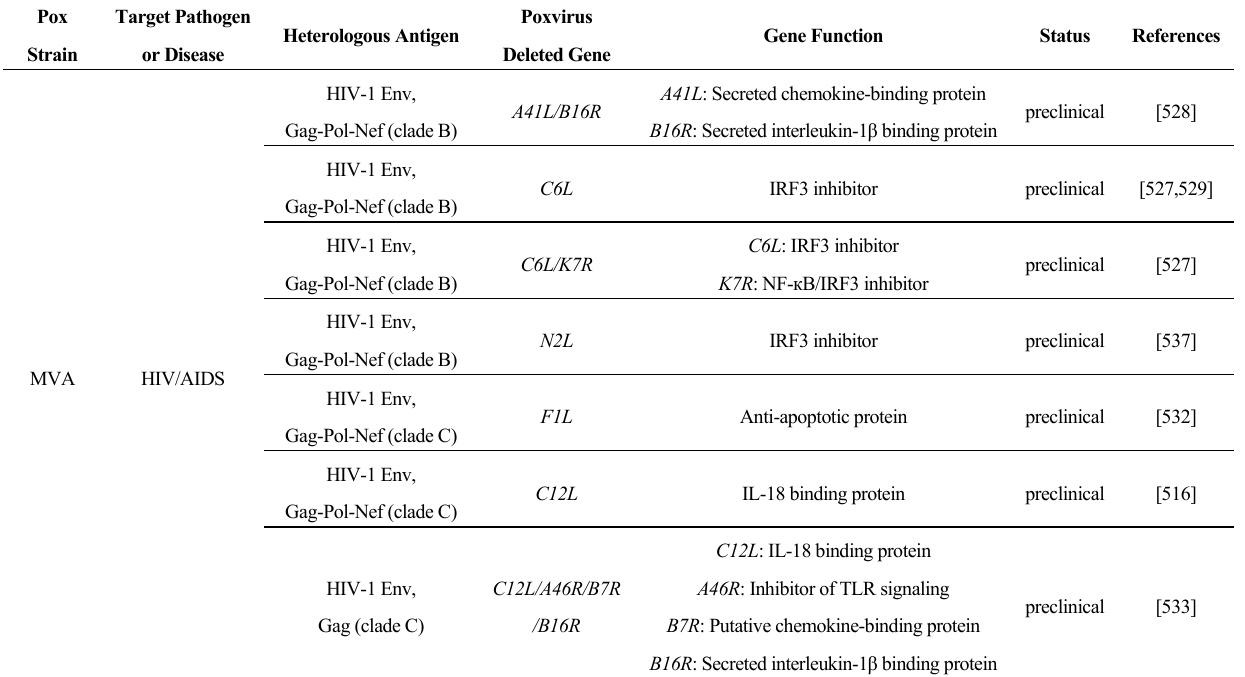
Table 9. Poxvirus genes deleted in poxvirus-based vaccine candidates against infectious diseases that enhance the vector